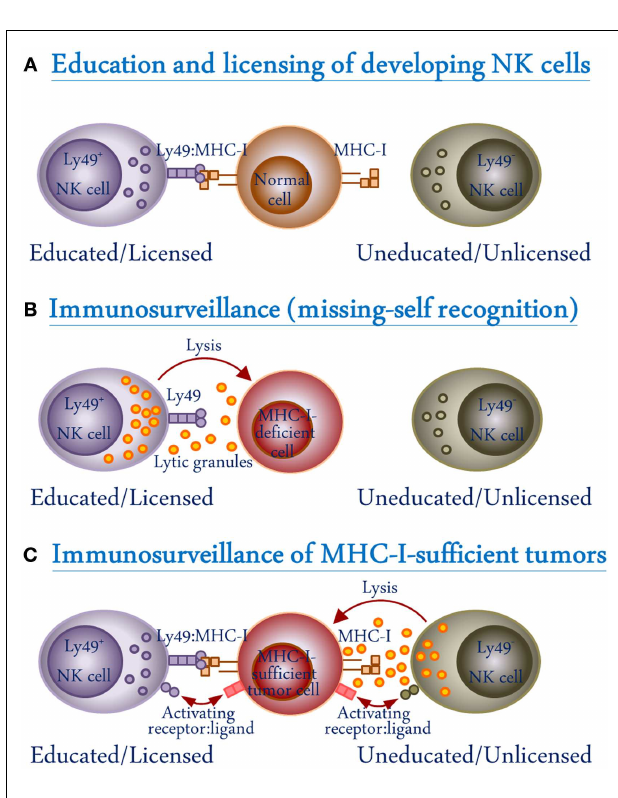
FIGURE 2 | Schematic representation of the role of Ly49 receptors in NK cell development and function . (A) During NK cell development, interactions between the inhibitory Ly49 receptors and their self-MHC-I ligands on normal cells result in NK cell functional maturation (education/licensing). (B) Licensed Ly49 + but not unlicensed Ly49 − NK cells recognize MHC-I-deficient cells and kill them through the release of lytic granules (missing-self recognition). (C) Tumor cells express ligands which are recognized by activating receptors on NK cells. However, MHC-I-expressing tumor cells can inhibit licensed NK cells through interactions with their inhibitory Ly49 receptors. Unlicensed NK cells will not be inhibited in this way because they lack Ly49 receptors.